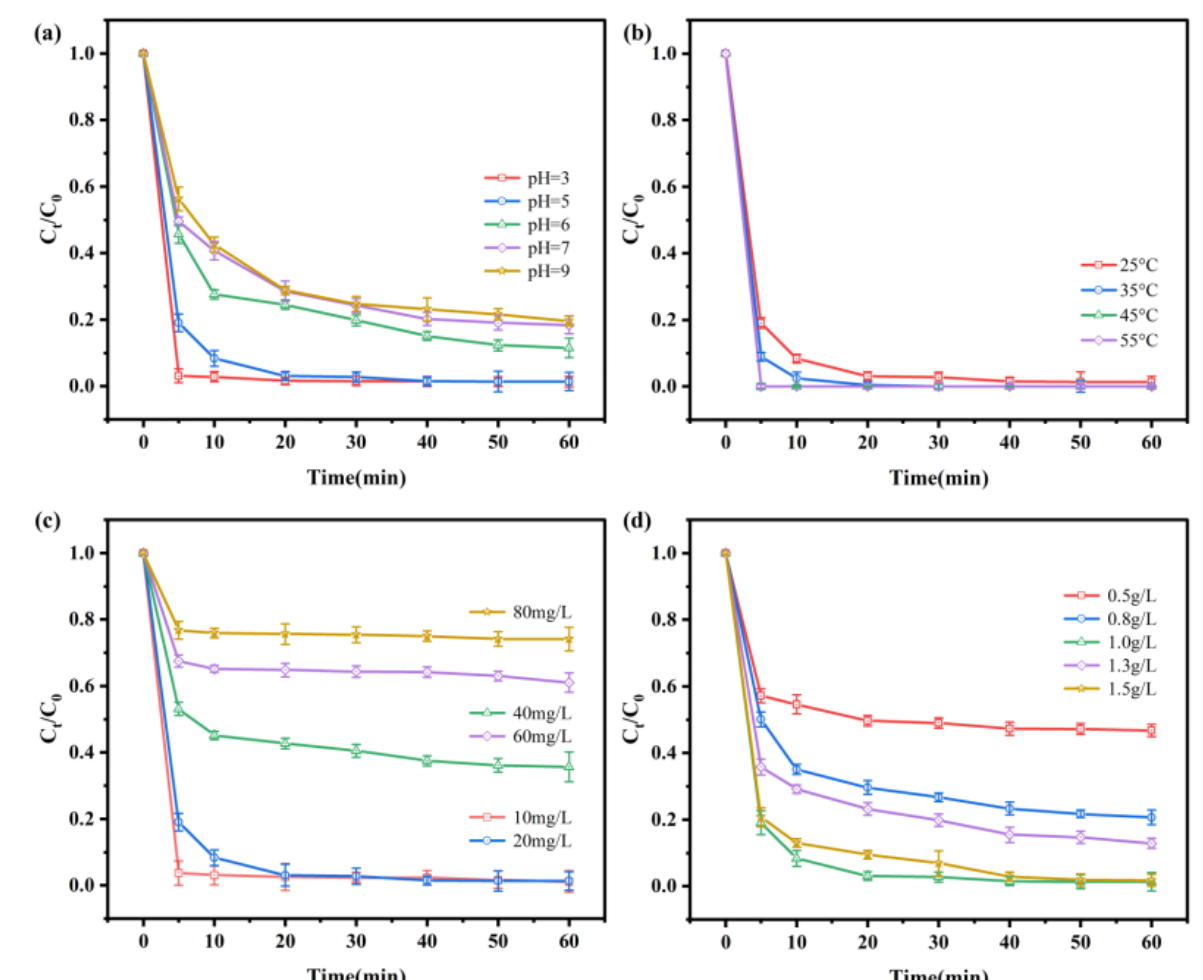
Figure 6. Cr(VI) removal at various pH values ( a ); at various temperature ( b ); at various initial concentration ( c ); at various dosages ( d ). Experimental conditions: initial Cr (IV) concentration 20 mg/L, RBC-nZVI dosage 1 g/L, T = 25 °C, pH = 5. Vertical bars denote the standard deviations of the means ( n = 2).